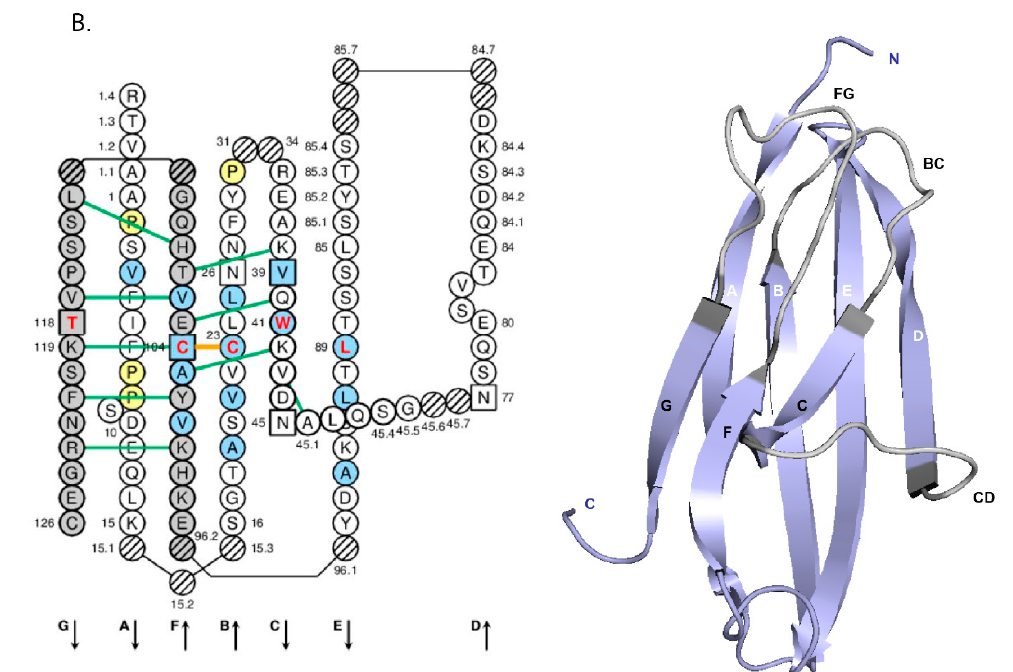
Figure 23. IMGT Collier de Perles of C-DOMAIN on two layers and ribbon representation [94]. ( A ) Trastuzumab CH1. ( B ) Trastuzumab C-KAPPA. The IMGT Colliers de Perles on two layers (on the left) show, in the forefront, the GFC strands and, in the back, the ABED strands (located at the interface CH1/C-KAPPA), linked by the CD transversal strand. The IMGT Colliers de Perles were generated by the IMGT/Collier-de-Perles tool [51] integrated in IMGT/3Dstructure-DB [57–59]. Hydrogen bonds (green lines online were automatically added from the experimental structural data). The disulfide bridge (orange line between C23 and C104) was also automatically added from the experimental structural data. Amino acids are shown in the one-letter abbreviation. Positions at which hydrophobic amino acids (hydropathy index with positive value: I, V, L, F, C, M, A) and tryptophan (W) are found in more than 50% of analysed sequences are shown online in blue. All proline (P) are shown online in yellow. Hatched circles correspond to missing positions according to the IMGT unique numbering for C domain [42]. Arrows indicate the direction of the beta strands and their designations in 3D structures. Anchors are shown in squares. The ribbon representation of the 3D structures (on the right) was obtained using PyMOL (http://www.pymol.org). The identifiers of the chains to which the domains belong are 1n8z_B and 1n8z_A (IMGT ® http://www.imgt.org, IMGT/3Dstructure-DB). (With